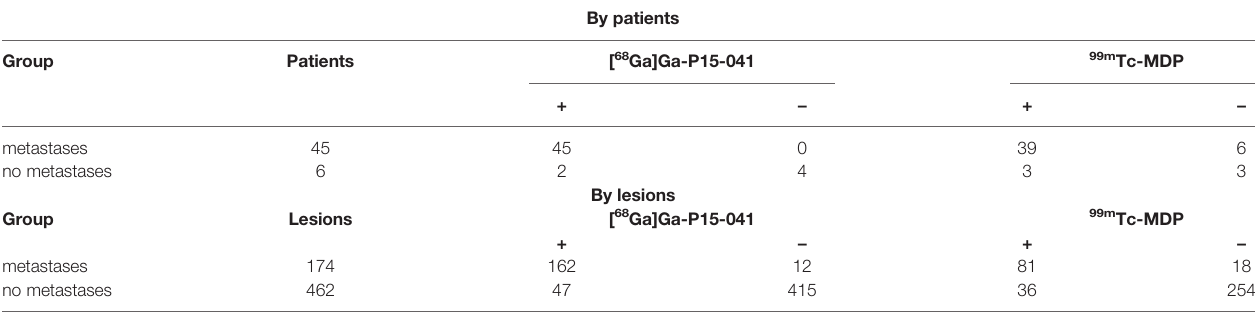
TABLE 3 | Patient-based and Lesion-based Metastases Detection on 68 Ga-P15-041 PET/CT and 99m Tc-MDP WBBS.